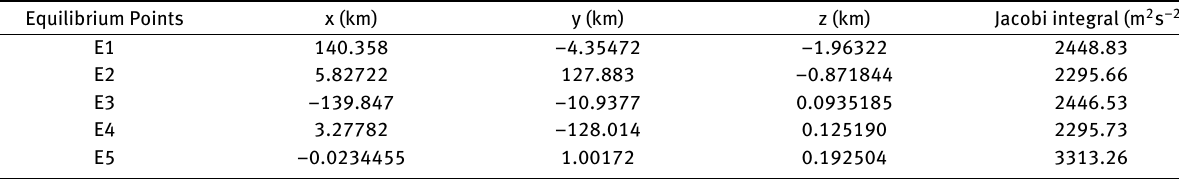
Table 1. Positions and Jacobi integrals of the equilibrium points around 45 Eugenia. Equilibrium Points